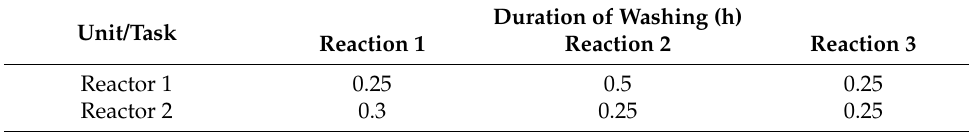
Table A8. Washing duration of various reactor units for case study 2 [7].